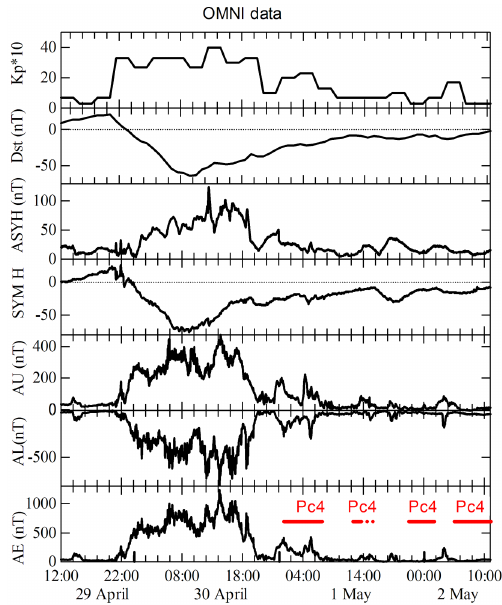
Figure 3. Kp, Dst, ring current and electrojet intensity indices from 12:00 UT on 29 April 2014 to 11:00UT on 2 May 2014 available from the OMNI database (http://omniweb.gsfc.nasa.gov/) . Solid red bars show intervals when Pc4 magnetic field pulsations were ob- served by multiple spacecraft. Dashed red bars indicate times when the Pc4 pulsations were observed in the electric field, not in the magnetic